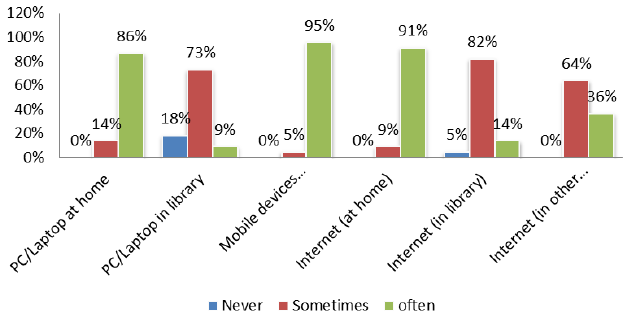
FIGURE 1 | Students’ Frequency in Using ICT for Learning Students’ Types of Language Learning Applications